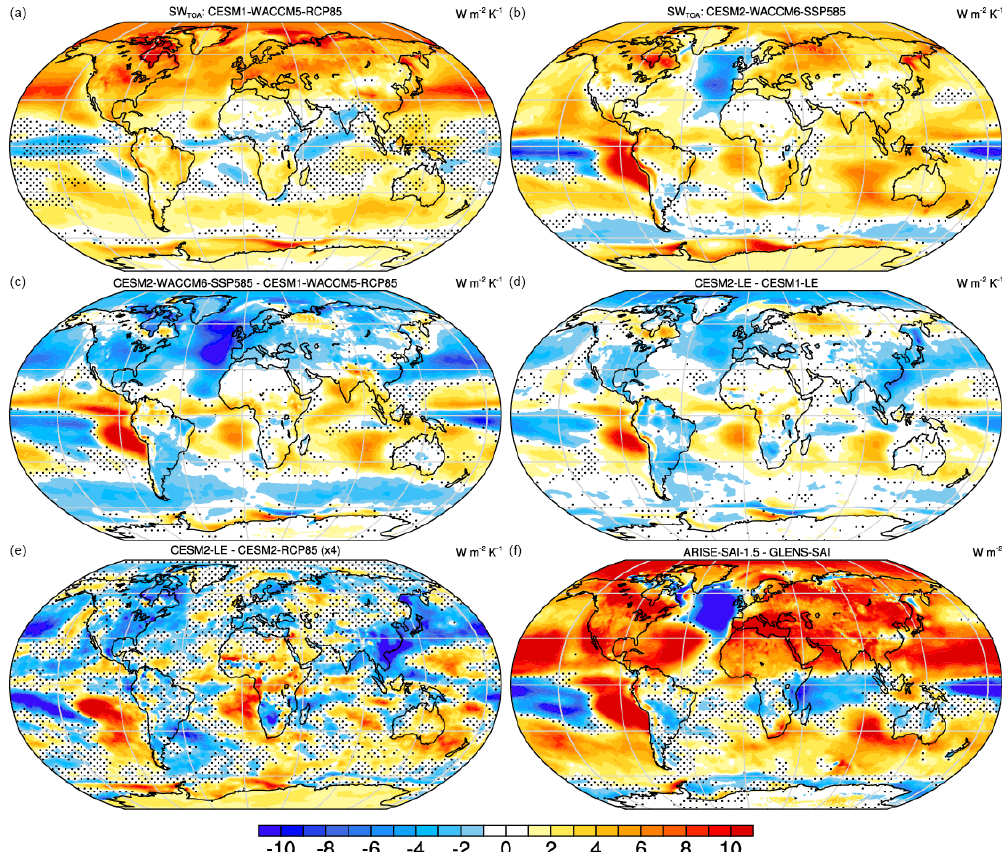
Figure 3. Normalized response in net absorbed top-of-atmosphere shortwave radiation (SW TOA ) estimated from the change between 2020– 2039 and 2050–2069 per degree global warming for unmitigated (a) CESM1-WACCM5-RCP85 and (b) CESM2-WACCM6-SSP585 simula- tions, and (c) their difference ( a minus b ). Also shown is (d) the analogous difference for CESM1-LE and CESM2-LE and (e) CESM2-RCP85 and CESM2-LE (multiplied by 4). The difference between the geoengineered climate states in ARISE-SAI-1.5 and GLENS-SAI is shown in panel (f) . Units for all panels are Wm − 2 K − 1 , except in panel (f) where units are Wm − 2 , and stippled regions indicate differences that are less than twice the ensemble standard